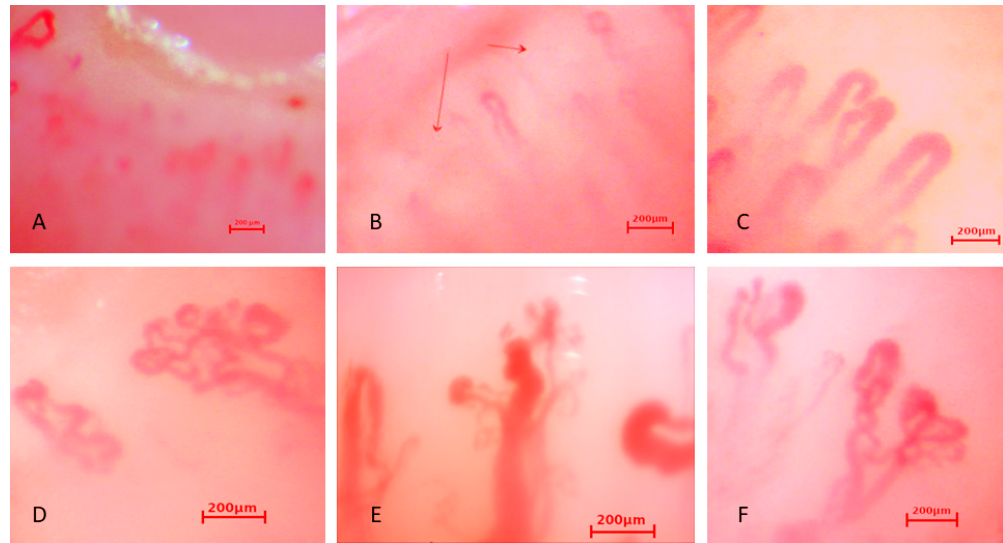
Figure 3. Capillaroscopic pictures of ( A , B ) reduced number of capillaries, ( C ) giant capillaries, ( D , F ) bizarre capillaries, ( E ) neoangiogenesis in the group with sRP.